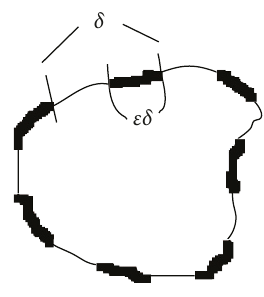
Figure 2.1 . Plane domain.